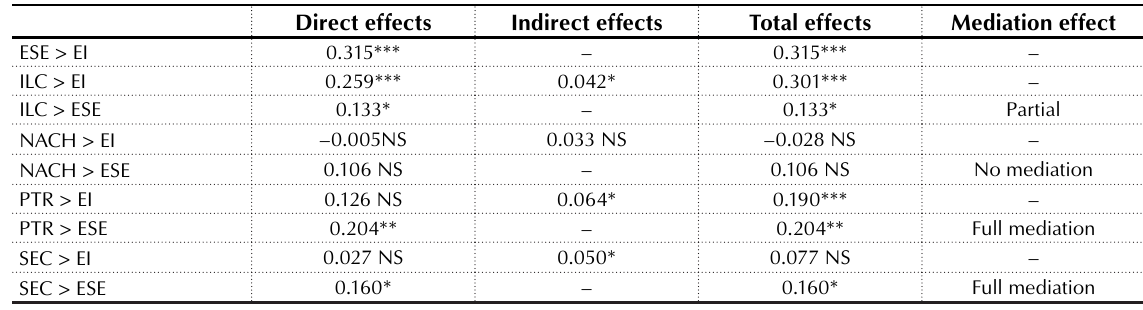
Table 5. Final mediation results